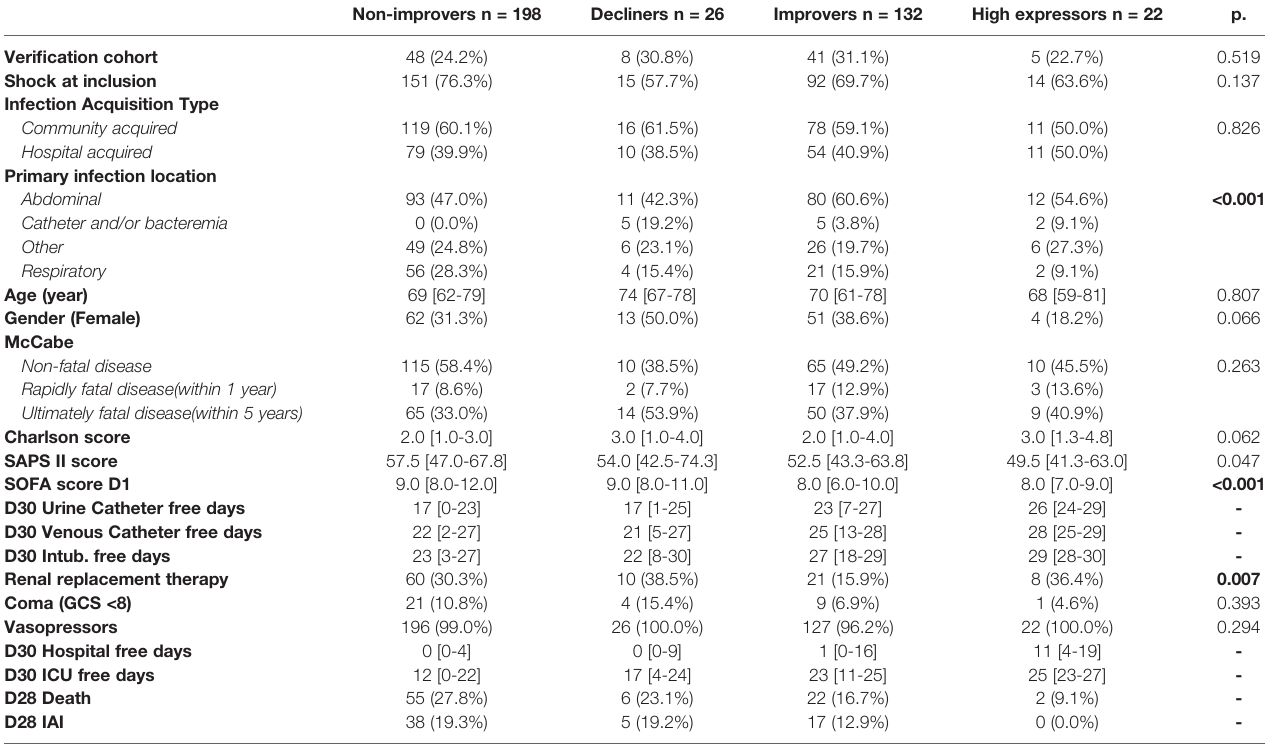
TABLE 2 | Aggregated Sepsis cohort mHLA-DR trajectories endotypes